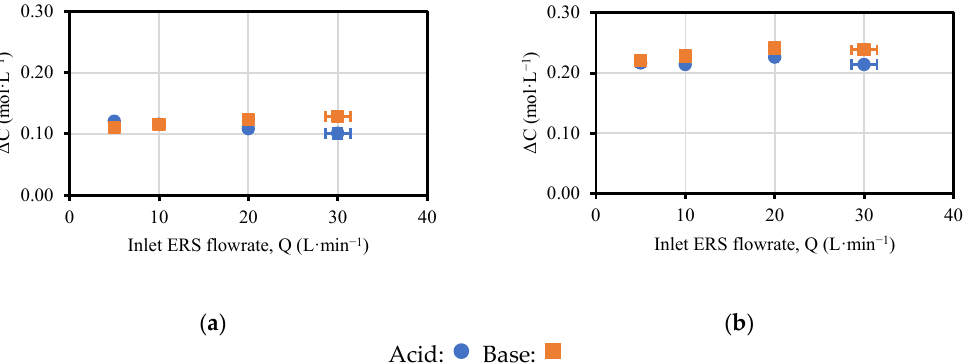
Figure 6. Values of concentration variation versus flowrate: ( a ) T ‐ 200 ‐ I ‐ ERS; ( b ) T ‐ 400 ‐ I ‐ ERS.